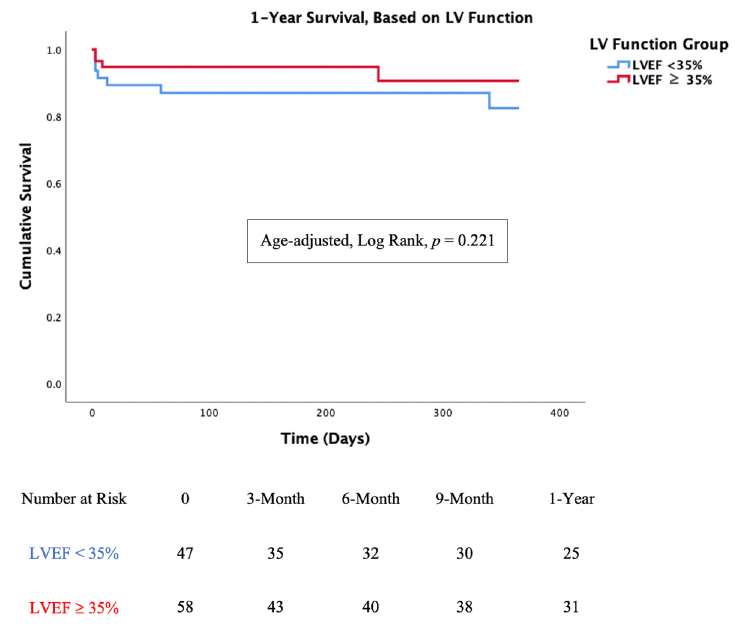
Figure 4. Kaplan-Meier curve for survival, based on LVEF. Left Ventricle Ejection Fraction (LVEF) was not associated with lower or higher mortality rate, Log Rank, p = 0.221.